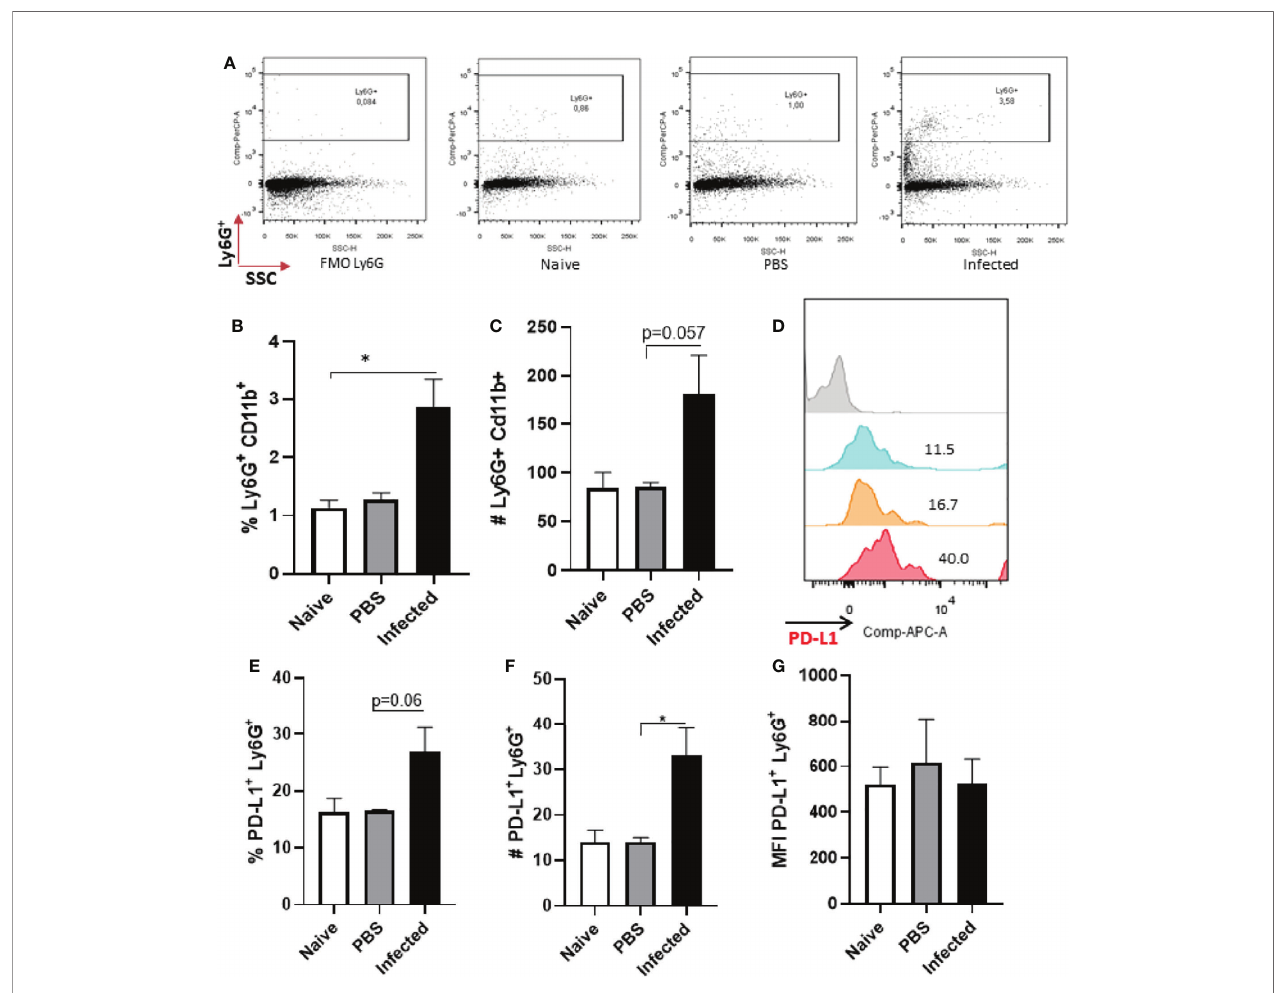
FIGURE 2 | Analysis of murine ear neutrophils after 12h of infection. Cells were collected from L. amazonensis -infected ears after 12h then submitted to fl ow cytometry. Controls were performed with uninfected (naïve) and PBS injected mice. (A) Dot plot showing Ly6G + cells (Ly6G-PerCP, SSC). (B) Percentage of Ly6G + CD11b + cells. (C) Number of Ly6G + CD11b + cells, p=0.057 (Mann-Whitney). (D) Histogram of PD-L1 expression. Grey = Fluorescence minus one control (FMO) PD-L1, Blue = Naïve, Orange = PBS and Red = Infected. (E) Percentage of PD-L1 + Ly6G + cells, p=0,06 (Mann-Whitney). (F) Number of PD-L1 + Ly6G + cells, p=0.06. (G) MFI of PD-L1 + Ly6G + . Data are mean ± SEM from cells of individual mice (N = 4-7 mice/group). *p < value